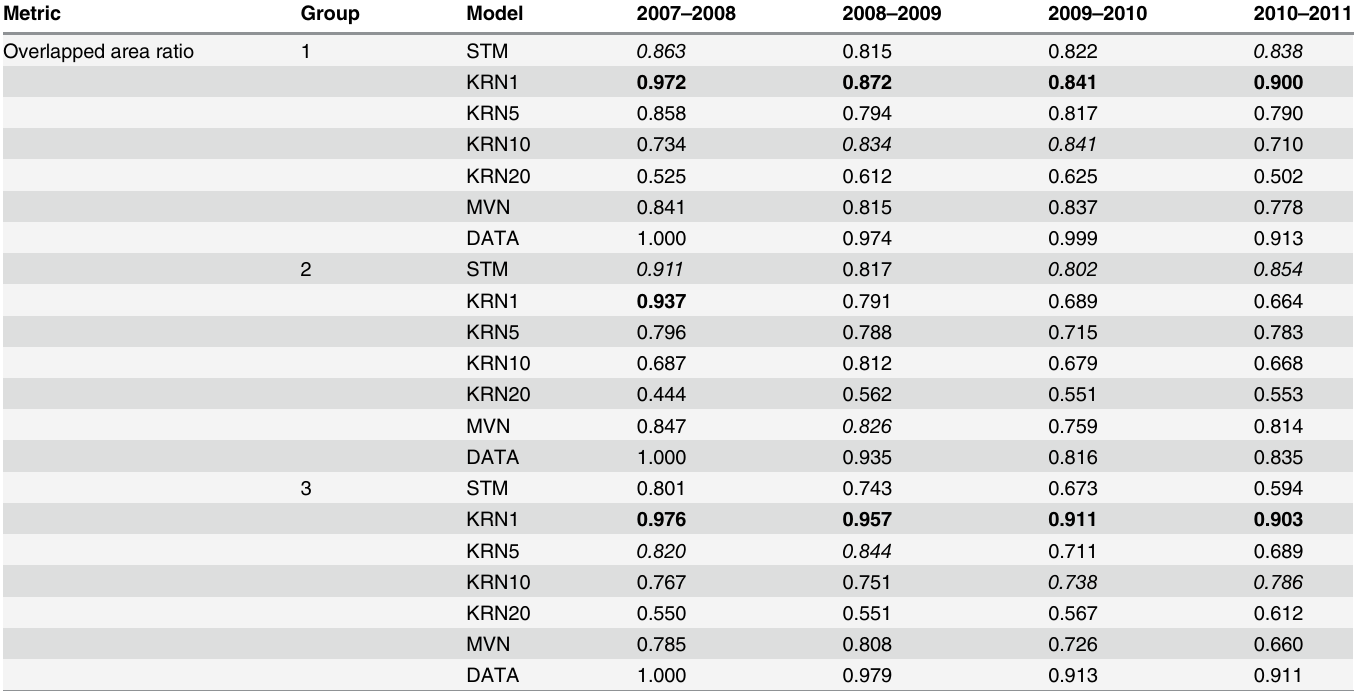
Table 5. The mean difference in overlapped convex hull ratio between the simulations and the data for the year. The numbers in bold indicate the best measure among the three models for each year. Italic numbers refer to the highest ratios in all models except KRN1. The rows marked as DATA show the overlapped convex hull ratio between the data of the year and that of year 2007 – 2008 for each group.